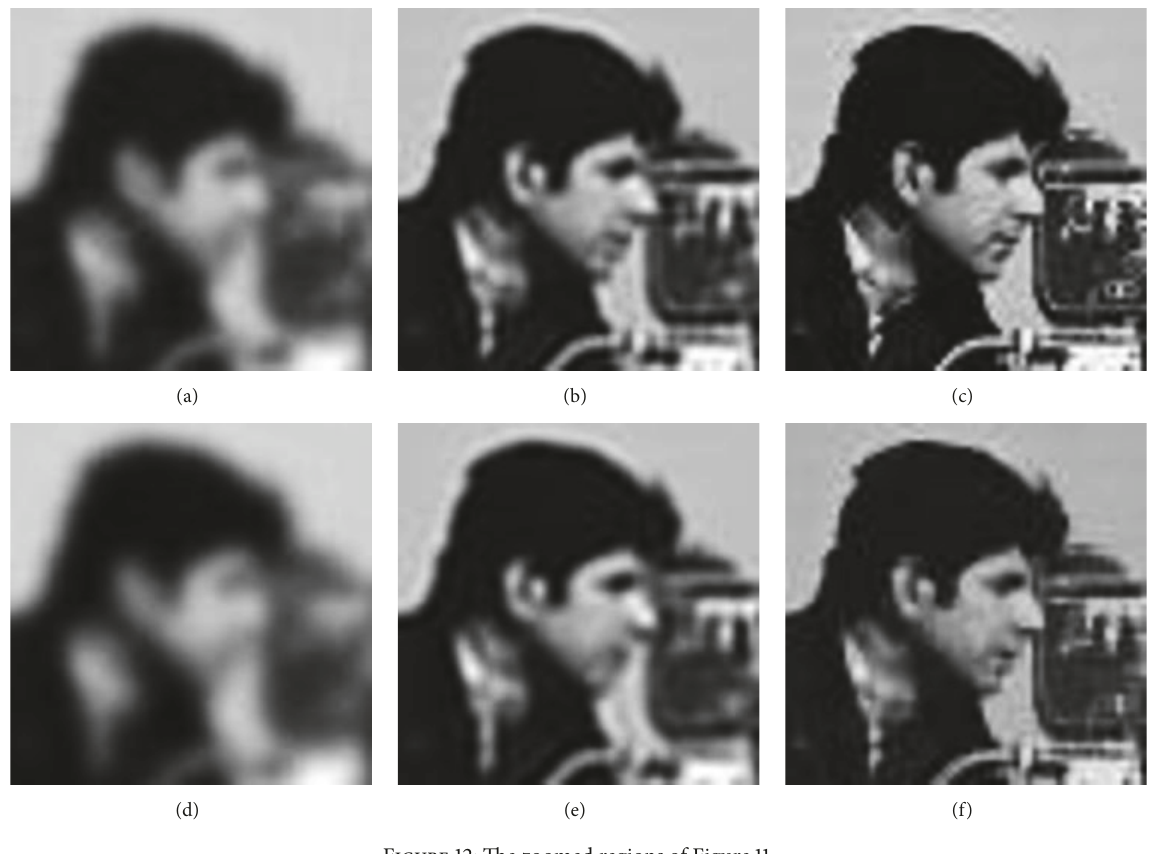
Figure 12: The zoomed regions of Figure 11. Table 5: Restoration results of different methods under out-of-focus blur with noise level 𝜎 = 0.1 . FTVd TGV TVframe